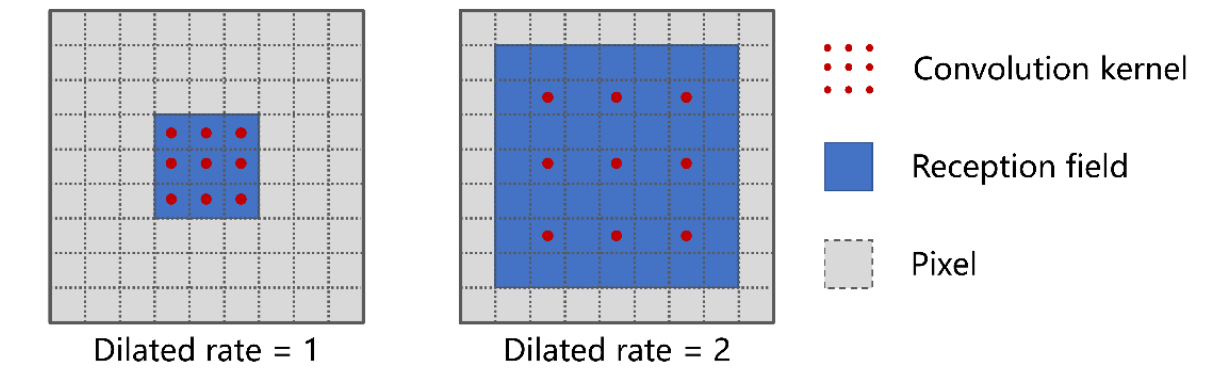
Figure 5. The dilated convolution layers.